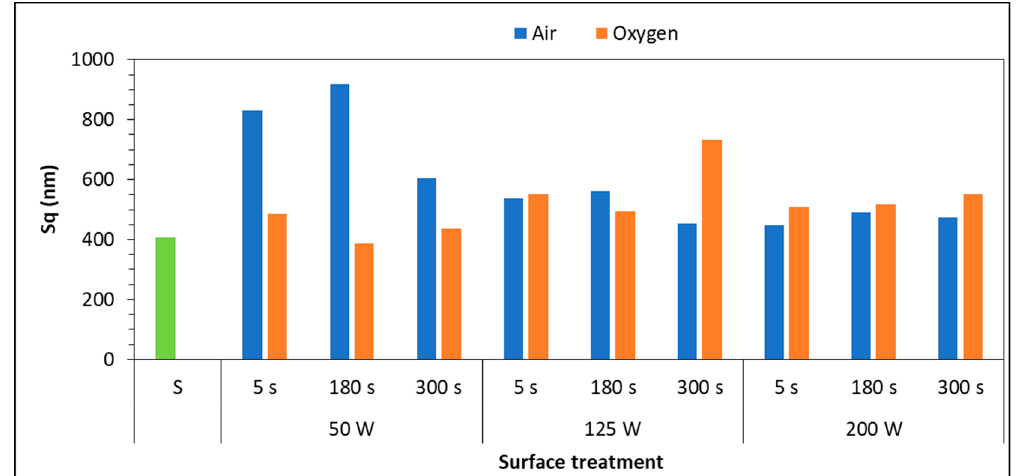
Figure 6. Surface roughness of PP substrates with respect to plasma treatment parameters.